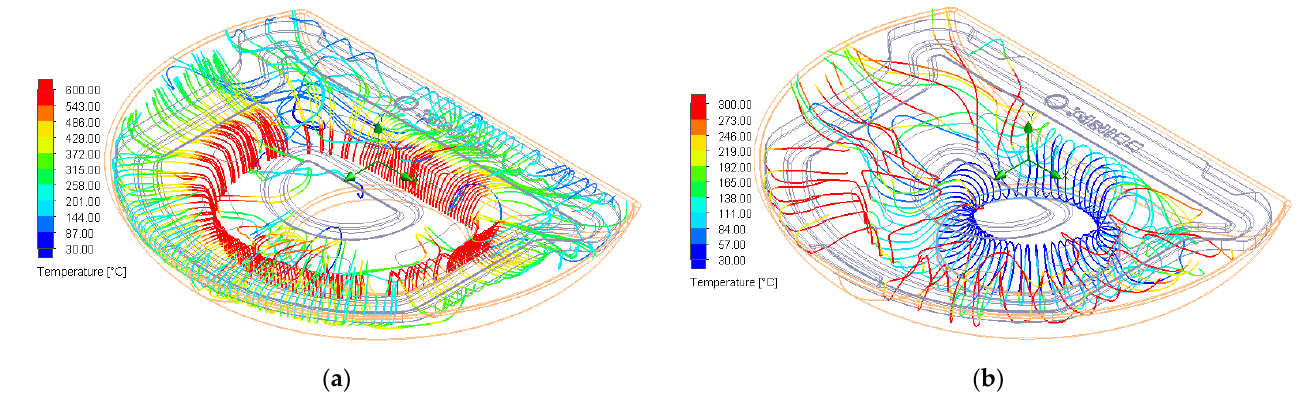
Figure 17. CA#3 ( a ) Burner streamline distribution (temperature); ( b ) Air inlet streamline distribu- tion (temperature).